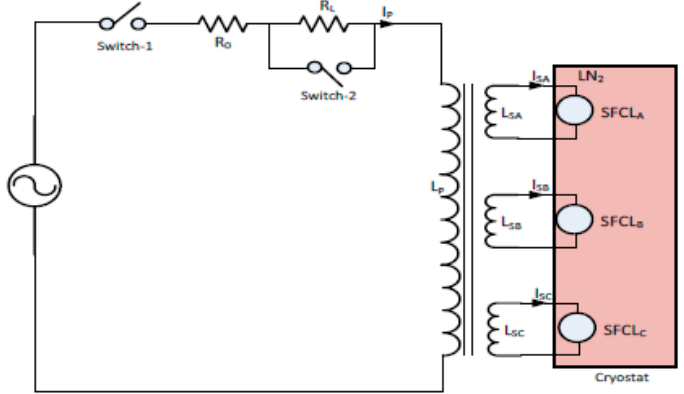
Figure 13. Configuration of hybrid SCFCL.